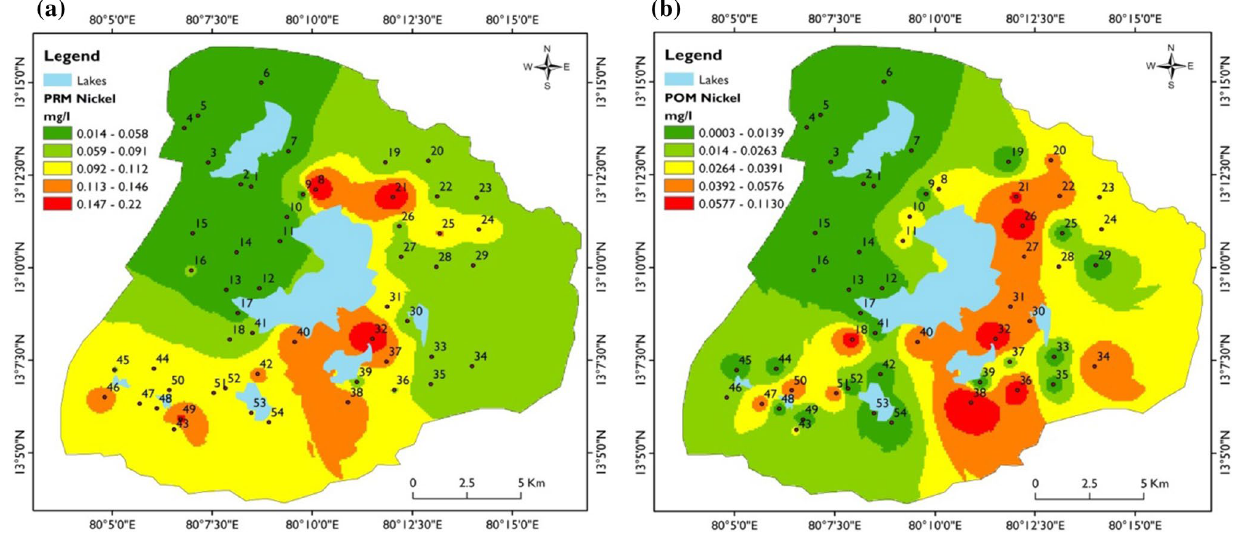
Fig. 6 a , b Spatial variation of Ni in the groundwater for pre-monsoon and post-monsoon, respectively